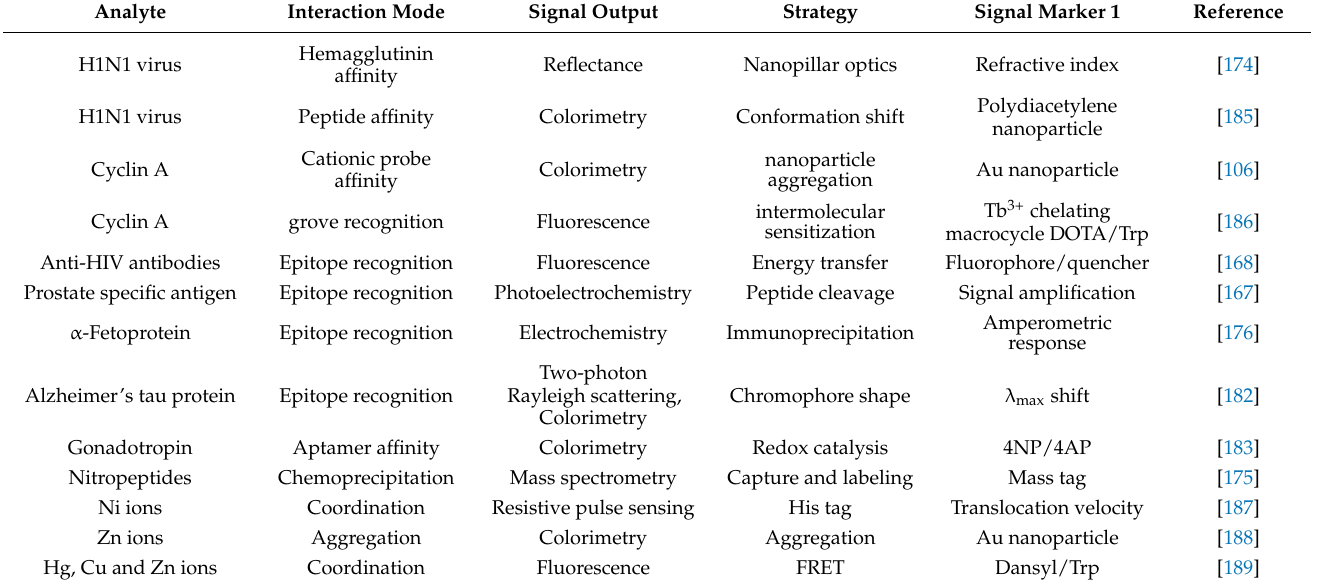
Table 2. Peptide-based sensors for non-enzymatic analytes. DOTA: